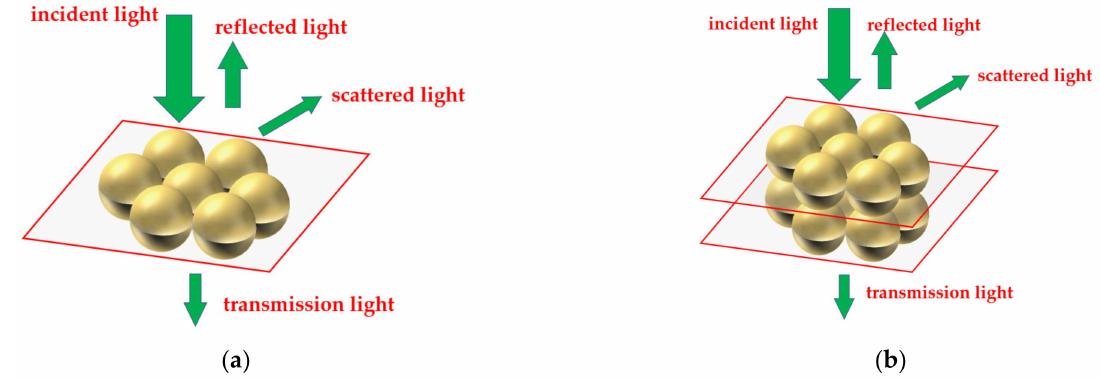
Figure 11. Interactions of Ag NPs with incident light and their geometry. ( a ) single-layer Ag NPs and ( b ) double-layer Ag NPs.